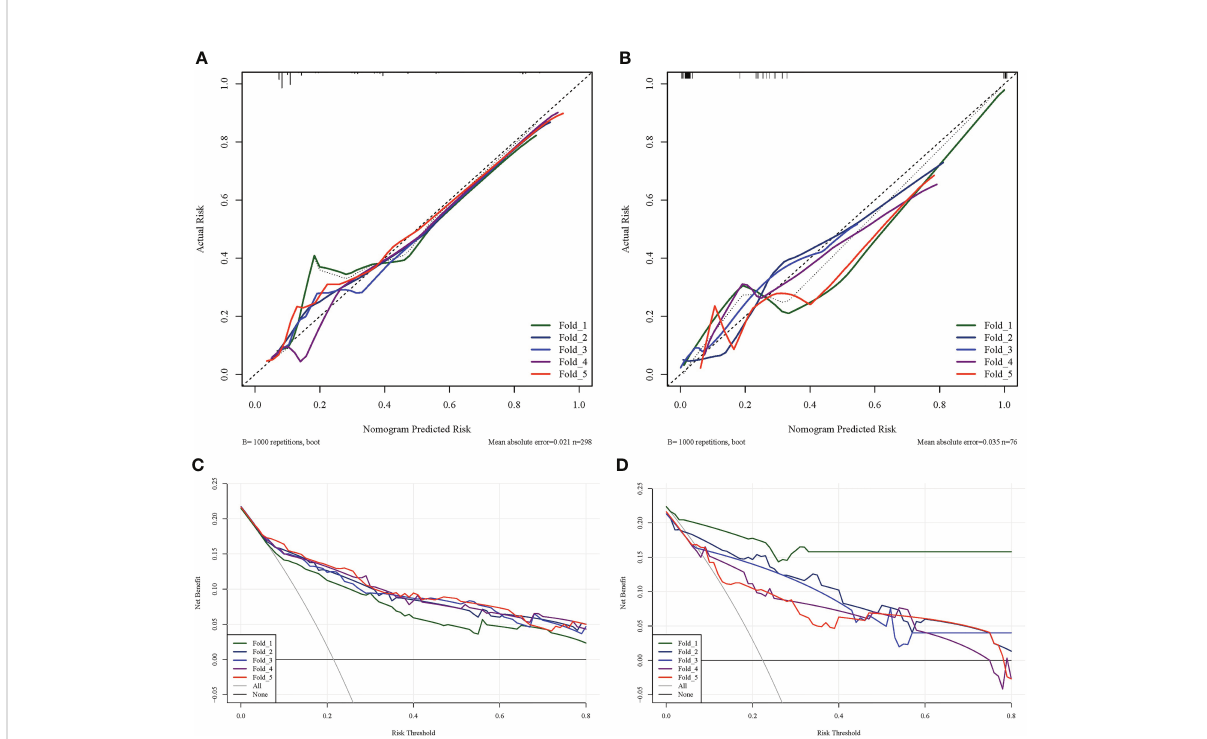
FIGURE 6 Calibration and decision curves of the R-R model. (A) The calibration curve of the R-R model in the training set. (B) The calibration curve of the R-R model in the validation set. The fi tness of the predicted probabilities of the R-R model to the actual results of the HGP was assessed. The x- axis represents the probability of HGP calculated using the R-R model, while the y-axis represents the actual probability of HGP. The diagonal line represents ideal estimates of the ideal model. (C) The decision curve of the R-R model in the training set. (D) The decision curve of the R-R model in the validation set. The x-axis represents the threshold probability and the y-axis represents net